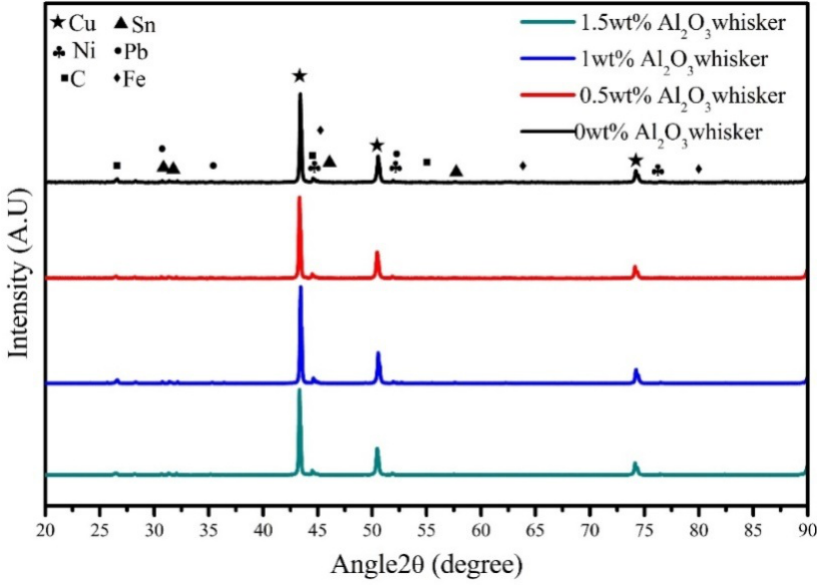
Figure 2. X-ray diffraction ( XRD) patterns of powder materials with different content of alumina